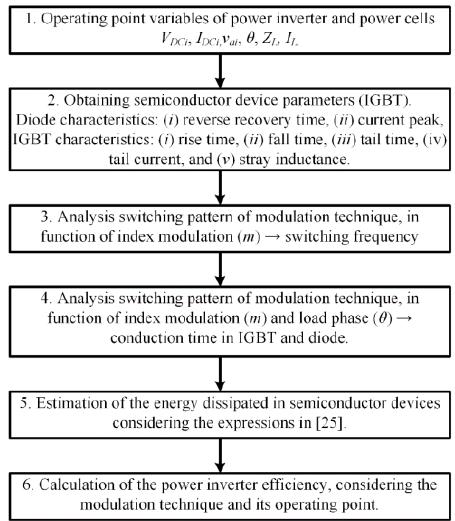
Figure 2. Methodology used to compute efficiency in 27 levels single-phase asymmetric inverter without regeneration.